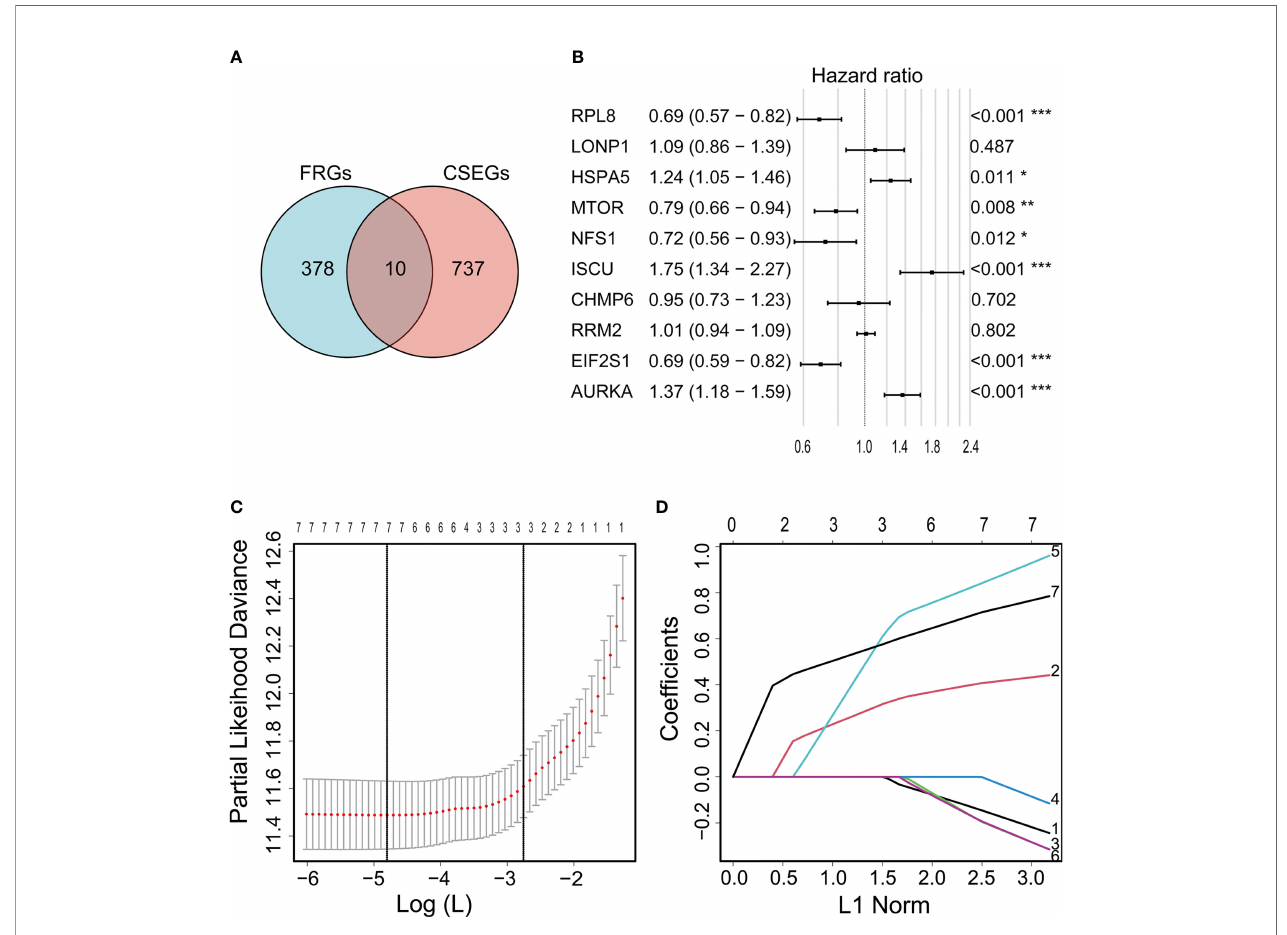
FIGURE 2 | Venn diagram showing overlap of 10 genes between the CSEGs and FRGs (A) . Top prognosis-associated candidate genes identi fi ed by Cox regression (B) . Re- fi ltering of genes in (B) by LASSO (C, D) . *p < 0.05, **p < 0.01, ***p <